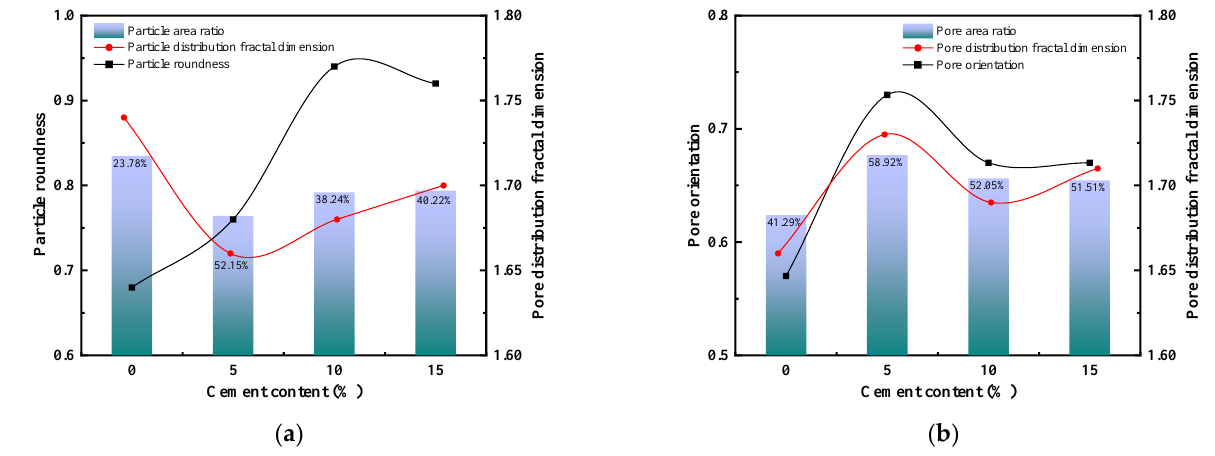
Figure 13. Variation law of microstructure characteristic parameters of silty clay with permeation grouting. ( a ) Particle characteristics. ( b ) Pore characteristics.